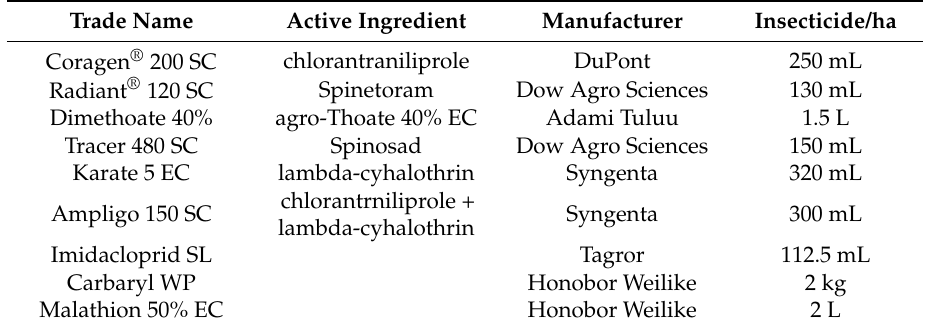
Table 1. List of synthetic insecticides, their active ingredients (a.i.), and suggested label rate used in the experiment against